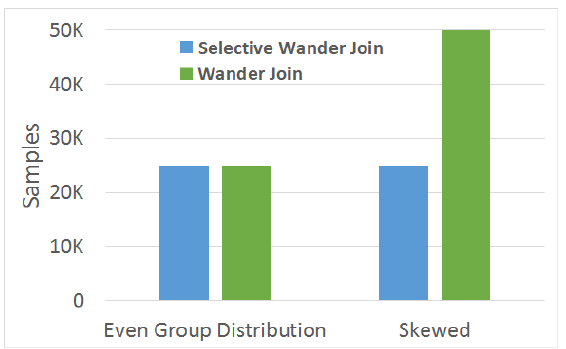
Figure 3. The number of samples needed for Wander Join and Selective Wander Join to achieve 0.05 relative error for all 40 groups in a GROUP BY query. Selective Wander Join and Wander Join require the same number of samples when the data is evenly distributed across all groups. However, Wander Join requires twice as many samples when 22% of data falls into 1 of the 40 groups. The more skewed the distribution is, the more samples Wander Join needs. Selective Wander Join samples evenly from all groups regardless of the